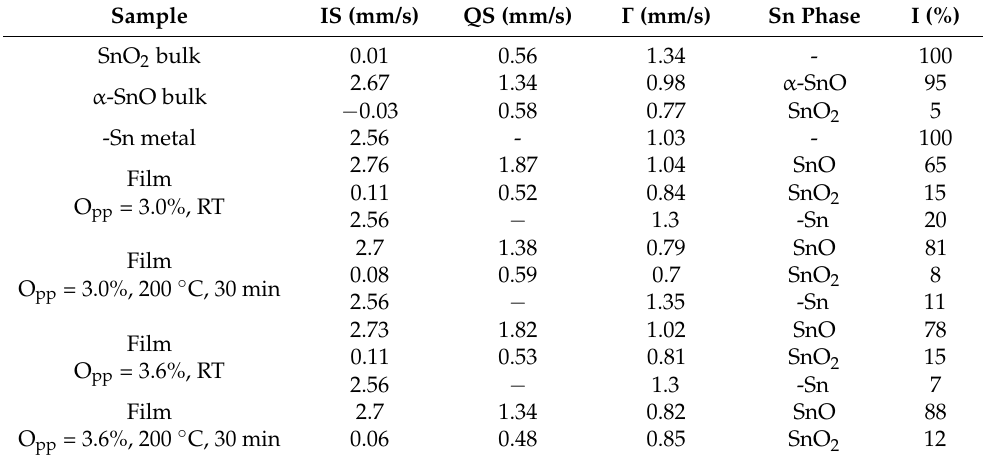
Table 3. Extrapolated parameters from the transmission 119 Sn Mössbauer spectra of bulk samples and CEMS spectra of films taken at